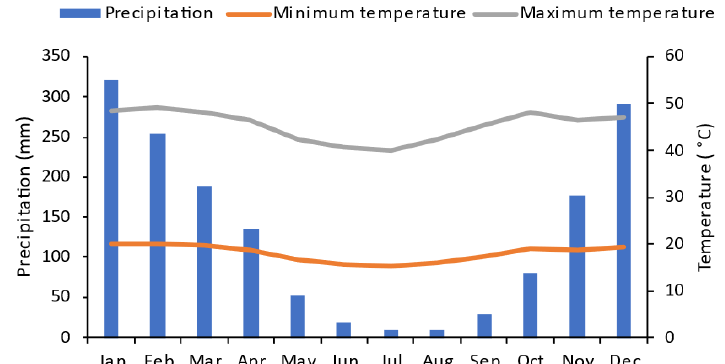
Figure 2. Average monthly precipitation (mm) and monthly minimum and maximum temperature between 2000 and 2021 at the Belo Horizonte conventional rainfall station.